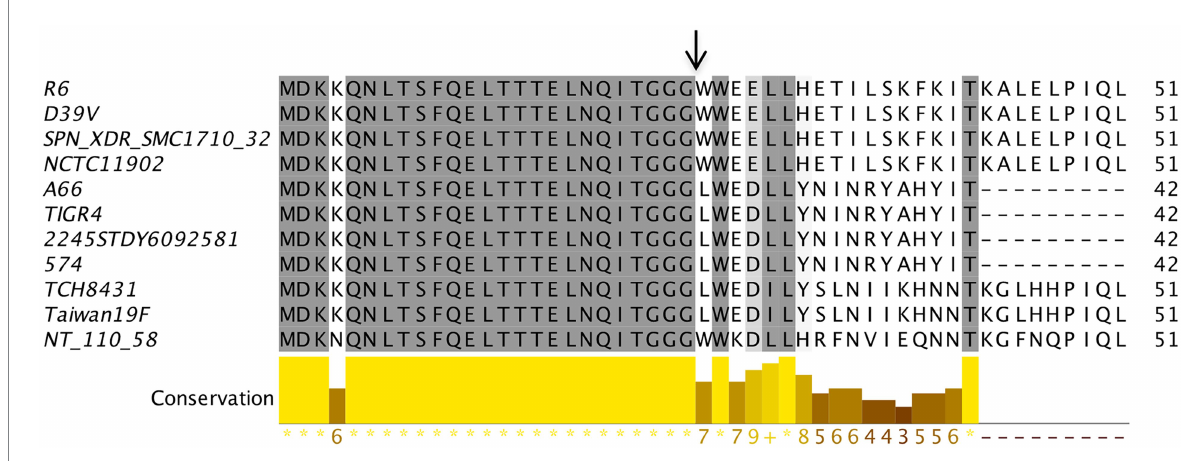
FIGURE 4 BlpC polymorphism in Streptococcus pneumoniae . The multiple sequence alignment of BlpC homologs from different S. pneumoniae strains was performed using Muscle with Jalview software. The residues that showed ≥ 60% conservation were highlighted by grey color. Graph bar represents conservation in each column. Arrow indicates the processing site to generate the mature